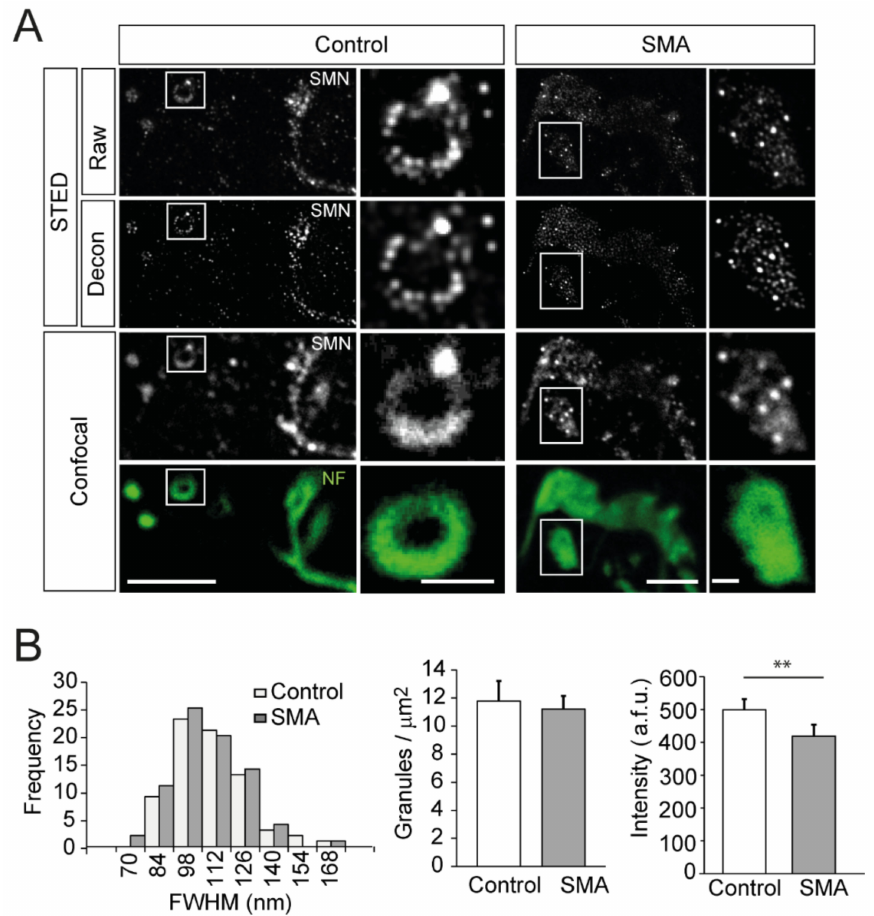
Figure 5. SMN granule properties visualized at super-resolution. ( A ). Comparison of immunofluo- rescence signals from SMN (white) with super-resolution and confocal microscopy in motor nerve terminals of the TVA muscle at P9. The super-resolution signals after deconvolution are also shown. The intraterminal axonal branches were labeled with antibodies against NFs (green). Note the ring- like (control) and the plaque-like (SMA) structures of the final part of the NFs branches and the ordered organization of granules in control. Scale bars: 5 µ m and 1 µ m (insets). ( B ). The apparent size distribution of SMA granules is similar in the control and SMA mice (left graph). The density of granules in the axonal branches is similar in both genotypes (middle graph). The mean granule intensity is lower in SMA mice (right graph; **: p < 0.005). a.f.u., arbitrary fluorescent